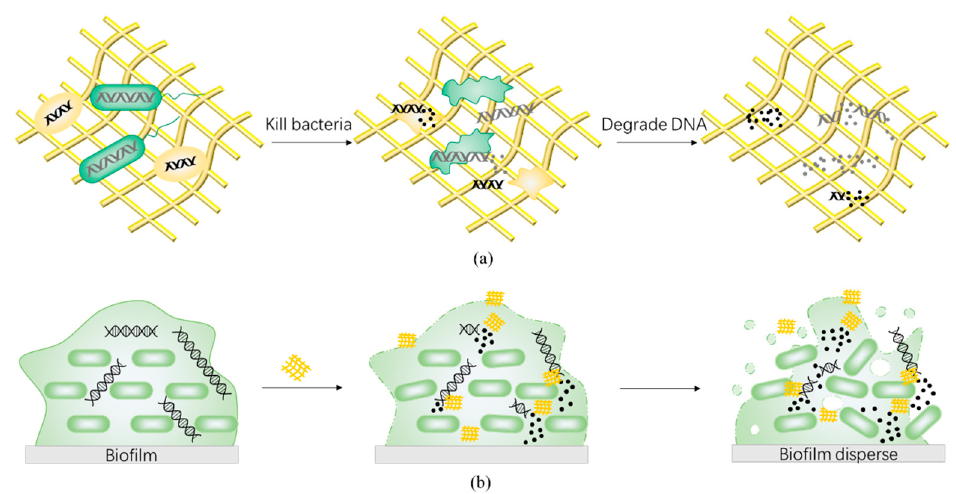
Figure 5. Schematic illustration of the antibacterial and antibiofilm mechanism of nanozybiotics based on nanozymes with deoxyribonuclease-like enzyme activities. Nanozymes with deoxyribonuclease activity catalyze the decomposition of DNA from dead bacteria to prevent the dissemination of released drug-resistant genes ( a ) and disperse the biofilm by decomposing the eDNA, the essential structural component of biofilm ( b ).